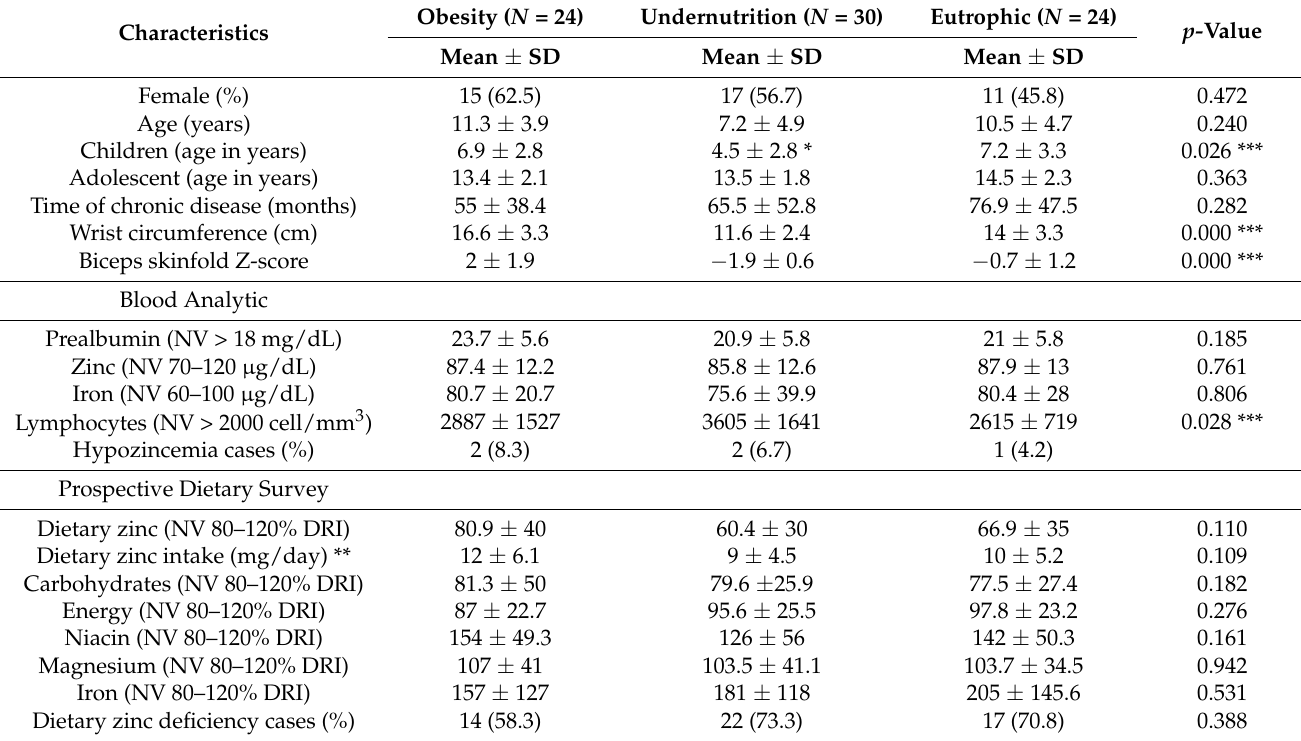
Table 1. Baseline characteristics of the children with chronic disease ( N = 78